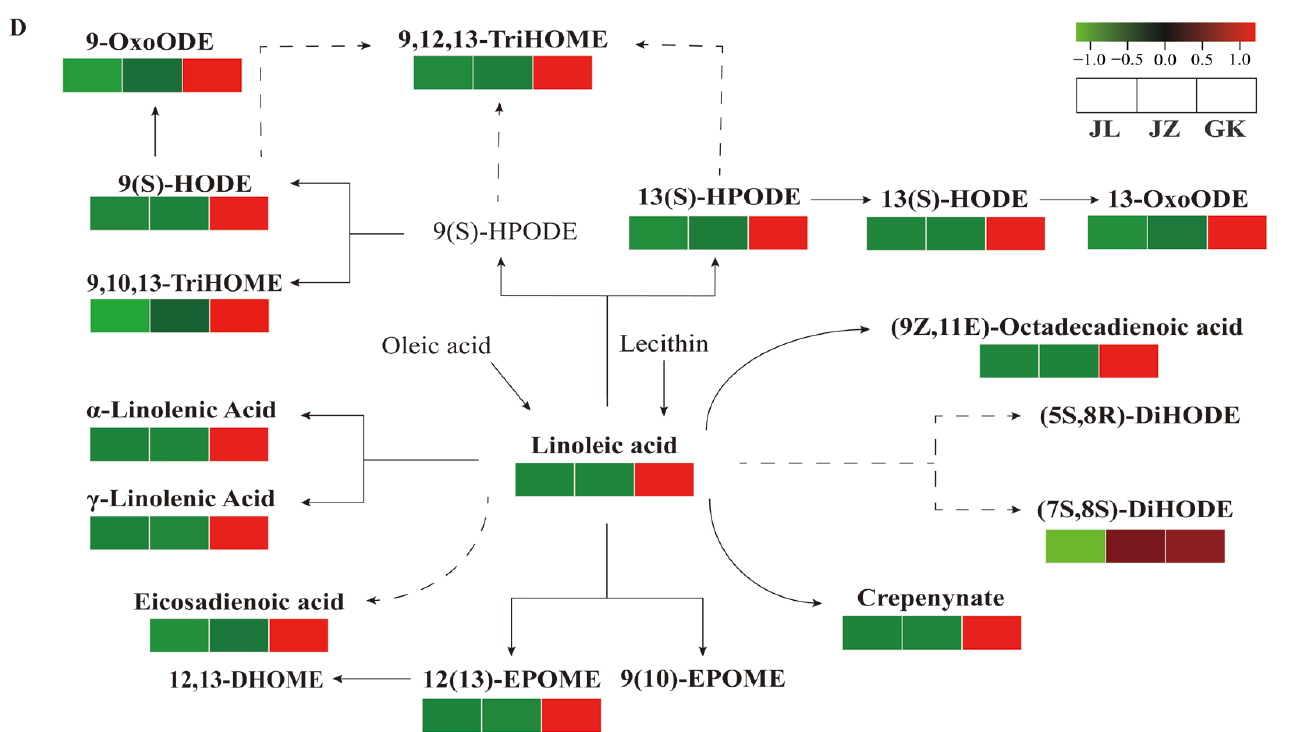
Figure 3. ( A – C ) KEGG enrichment plots of differential metabolites from different germplasms comparison groups, ( A ) JL vs. GK, ( B ) JZ vs. GK, ( C ) JZ vs. JL, ( D ) Distribution of differential metabolites from different germplasms P. cyrtonema linoleic acid and unsaturated fatty acid biosynthetic pathways, grey font represents non-detected metabolites, solid arrows represent individual reactions, and the dashed arrows indicate conversions with multiple steps catalysed.